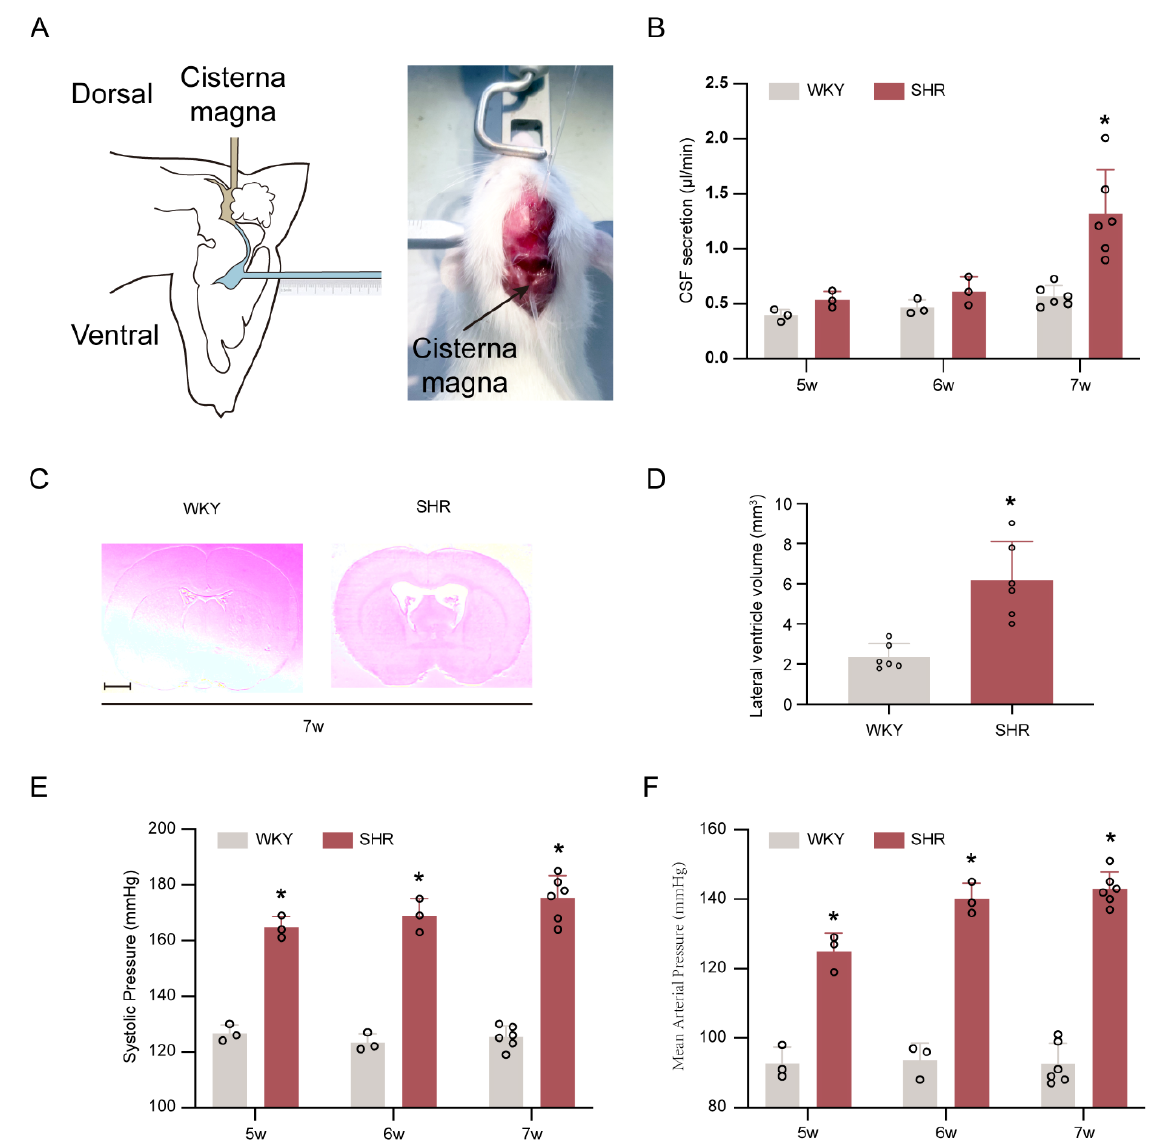
Figure 1. CSF hypersecretion and hydrocephalus occurs in SHRs at seven weeks of age. ( A ) Left, schematic of the method used for in vivo quantification of CSF secretion in rats. Right, direct measurement of CSF secretion in a live rat. ( B ) Quantification of the rate of CSF secretion at weeks 5 ( n = 3), 6 ( n = 3), and 7 ( n = 6). * p < 0.05 versus WKY rats at week 7. ( C ) Representative photomicrographs of coronal sections of rat brains (at − 0.6 mm from the bregma) depicting ventricular volume at week 7 in SHRs compared with age-matched WKY rats. Scale bar, 2 mm. ( D ) Quantification of lateral ventricle volume in SHRs ( n = 6) and WKY rats ( n = 6) at weeks 7. * p < 0.05 versus WKY rats at week 7. ( E , F ) SHRs had significantly higher systolic blood pressure and mean arterial pressure than WKY rats at weeks 5 ( n = 3), 6 ( n = 3), and 7 ( n = 6). * p < 0.05 versus WKY group. Values are means ±